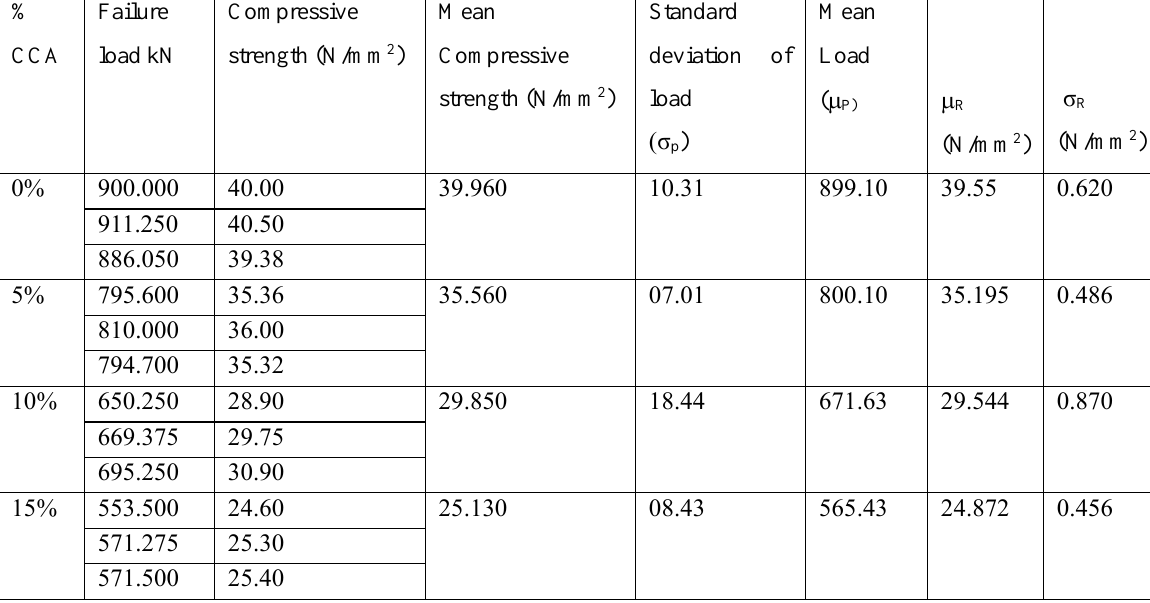
compressive strength of 56 days using FOSM